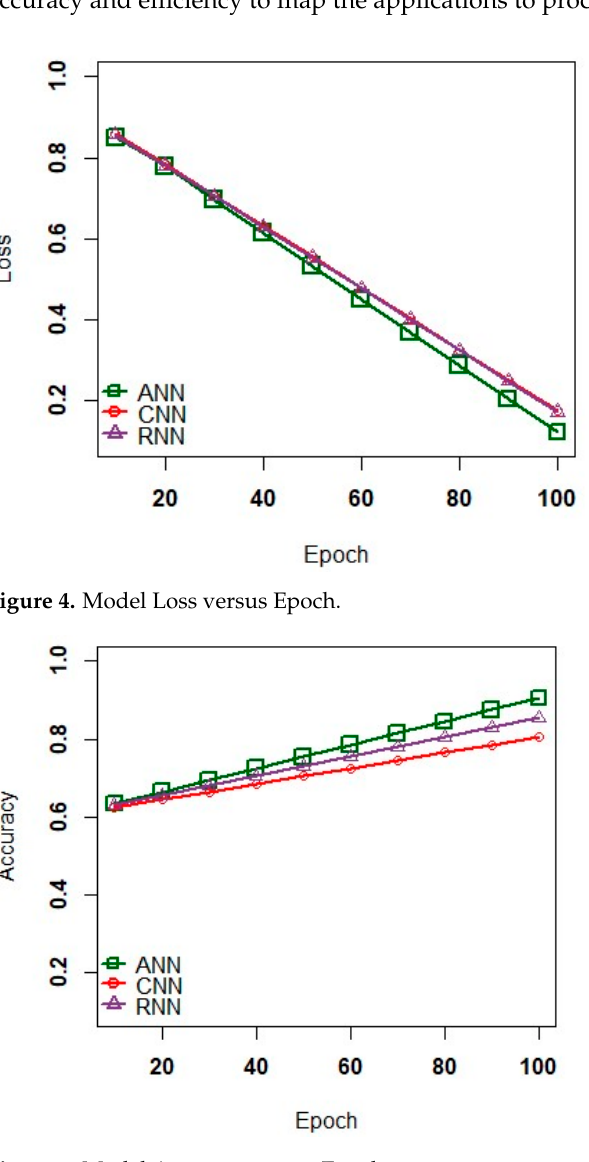
Figure 5. Model Accuracy versus Epoch.